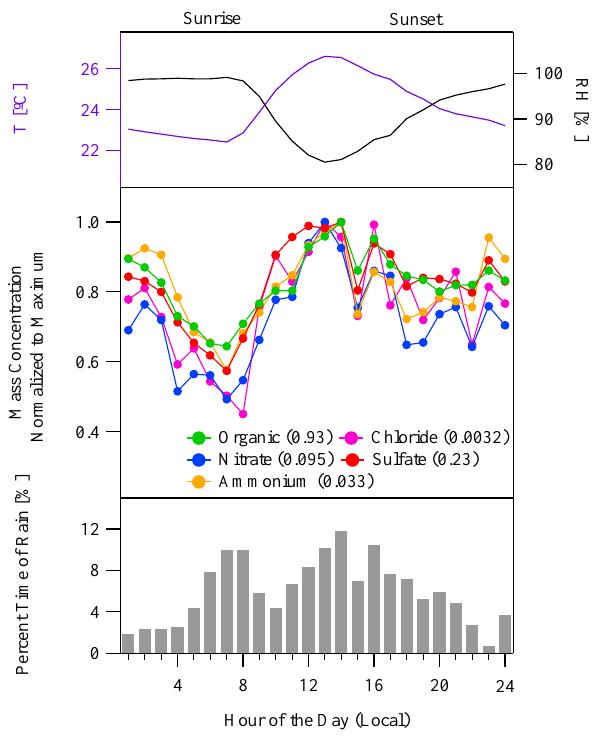
Figure 3. Diel profiles of (top) the temperature and relative humid- ity at the top of the measurement tower, (middle) normalized AMS- measured speciated mass concentrations (maximum concentrations in µgm − 3 (STP) are shown in parentheses), and (bottom) percent occurrence of rain. Data represent mean